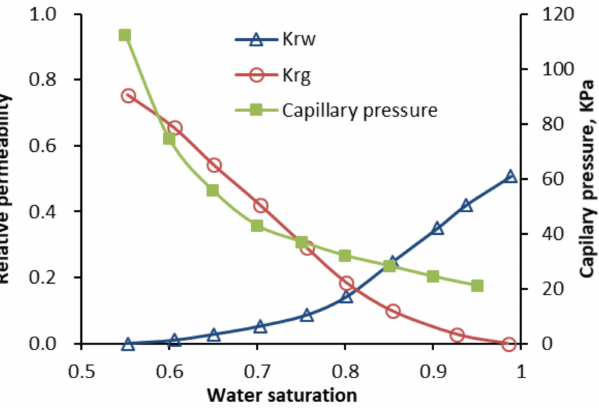
Figure 6. Reference relative permeability and capillary pressure for the synthetic core flooding test.